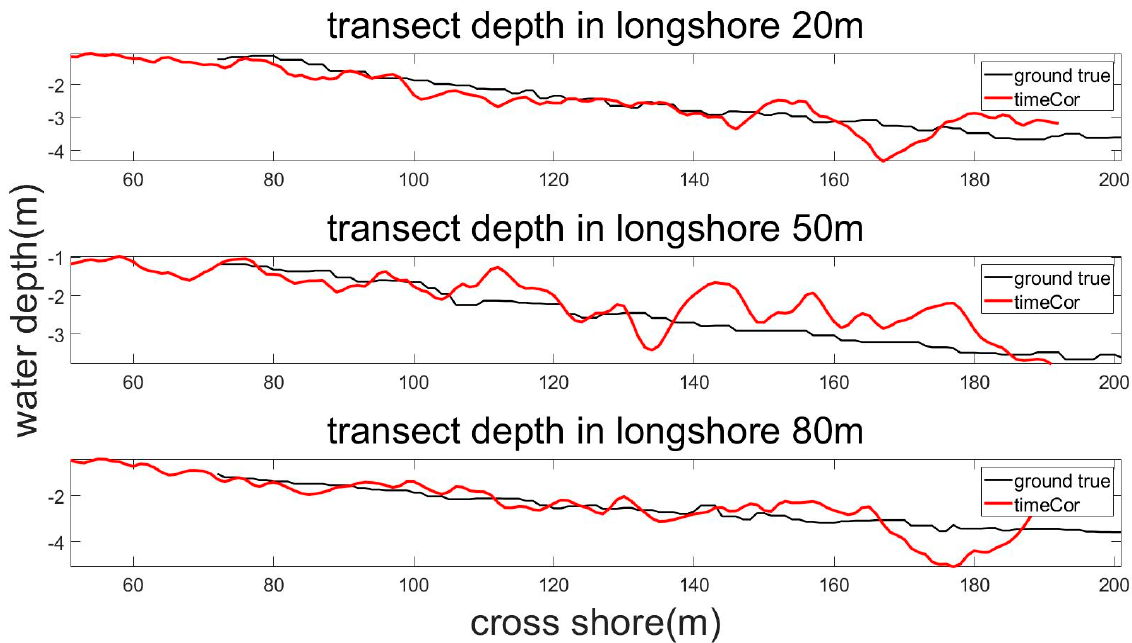
Figure 15. Comparison between ground true and the timeCor result.